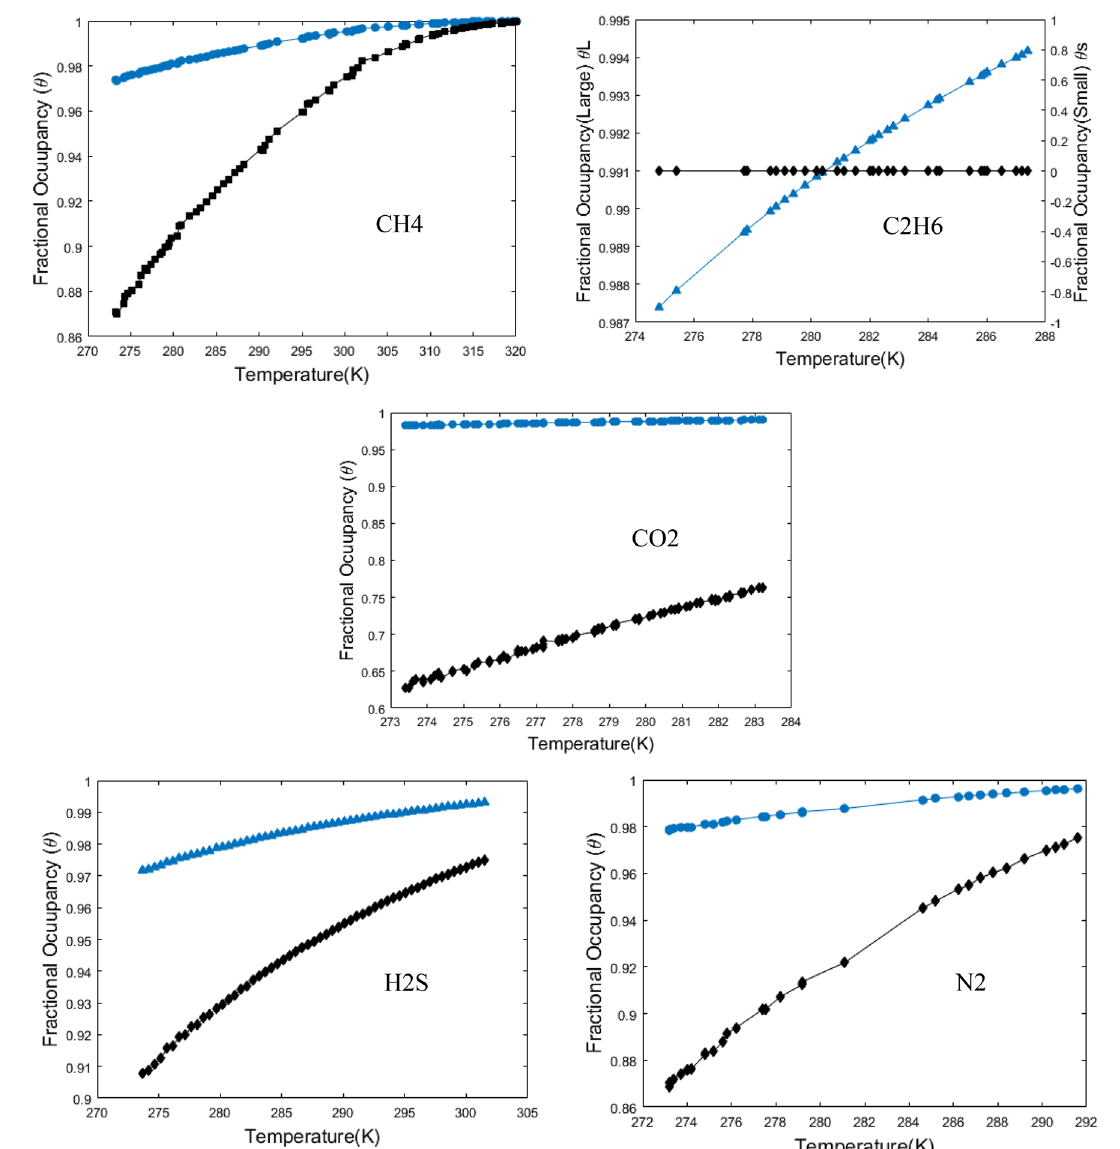
Fig. 20 Fractional cage occupancies for the different hydrates, blue line (large), black